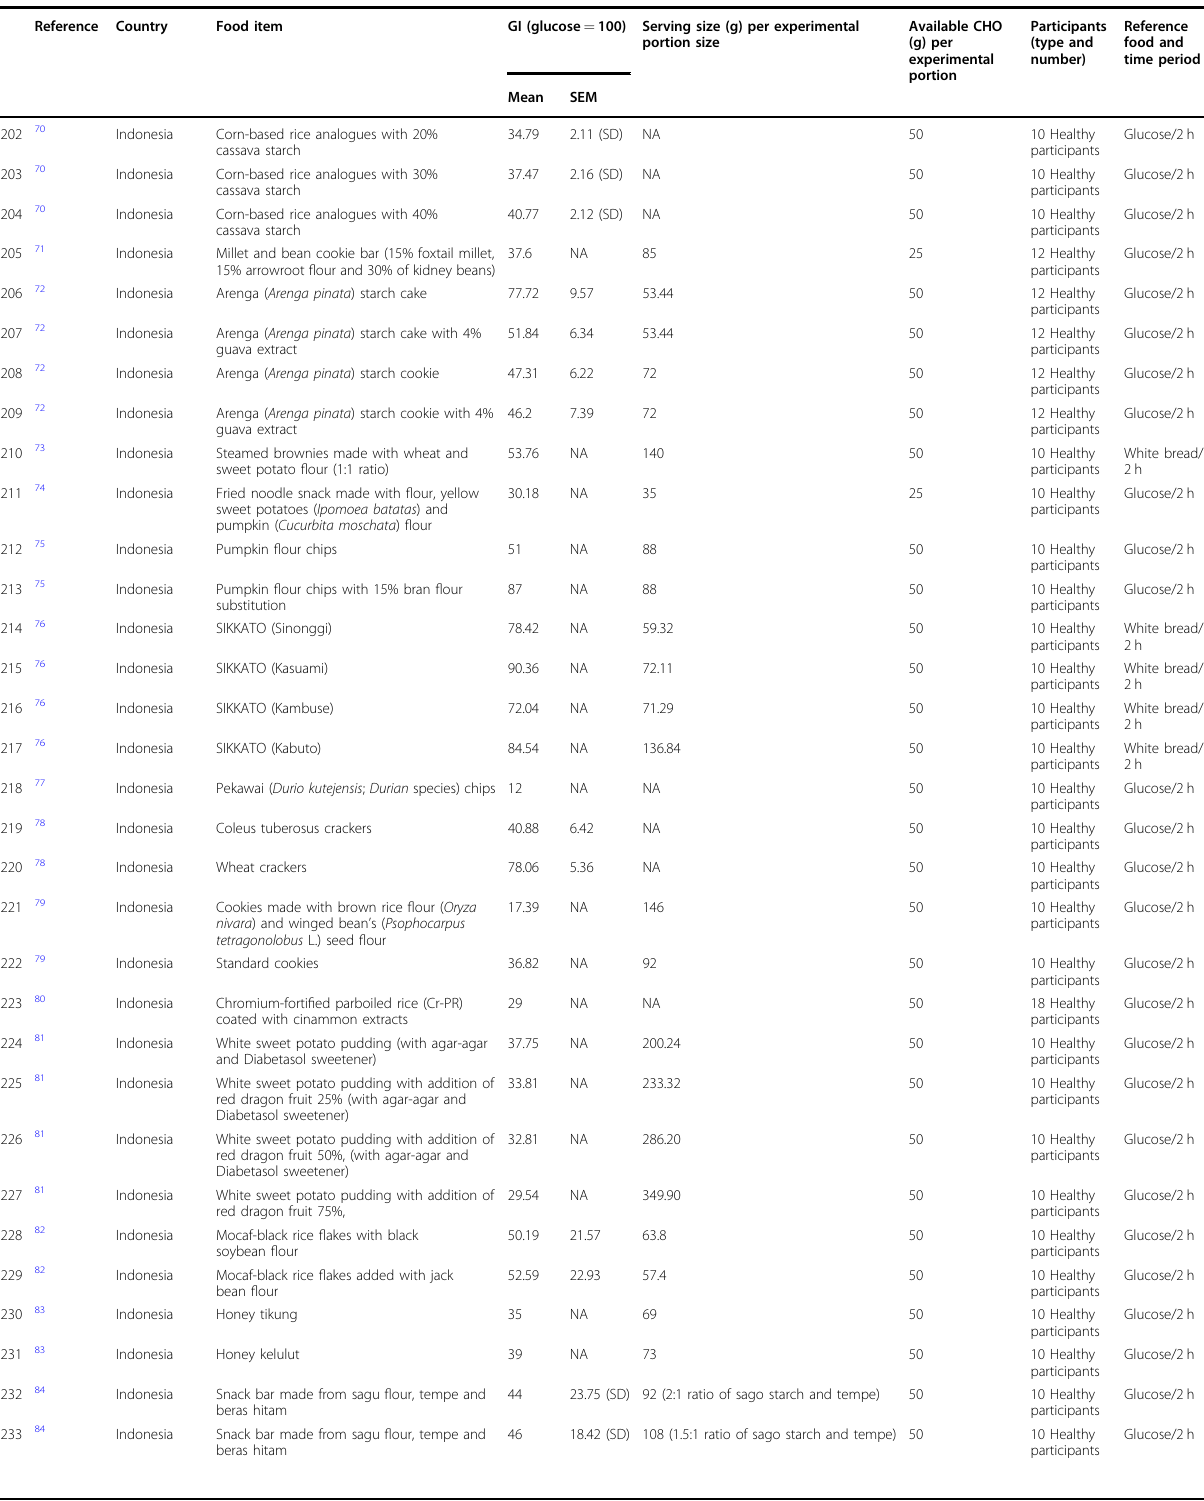
Snack bar made from sagu fl our, tempe and beras hitam